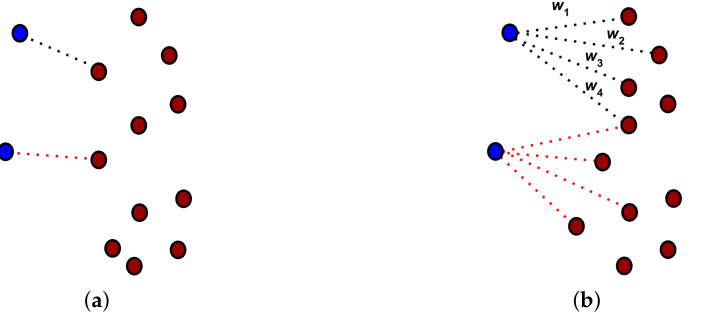
Figure 1. The two different data association policies. ( a ) Iterative Closest Point (ICP) Data Association ( b ) Probabilistic Data